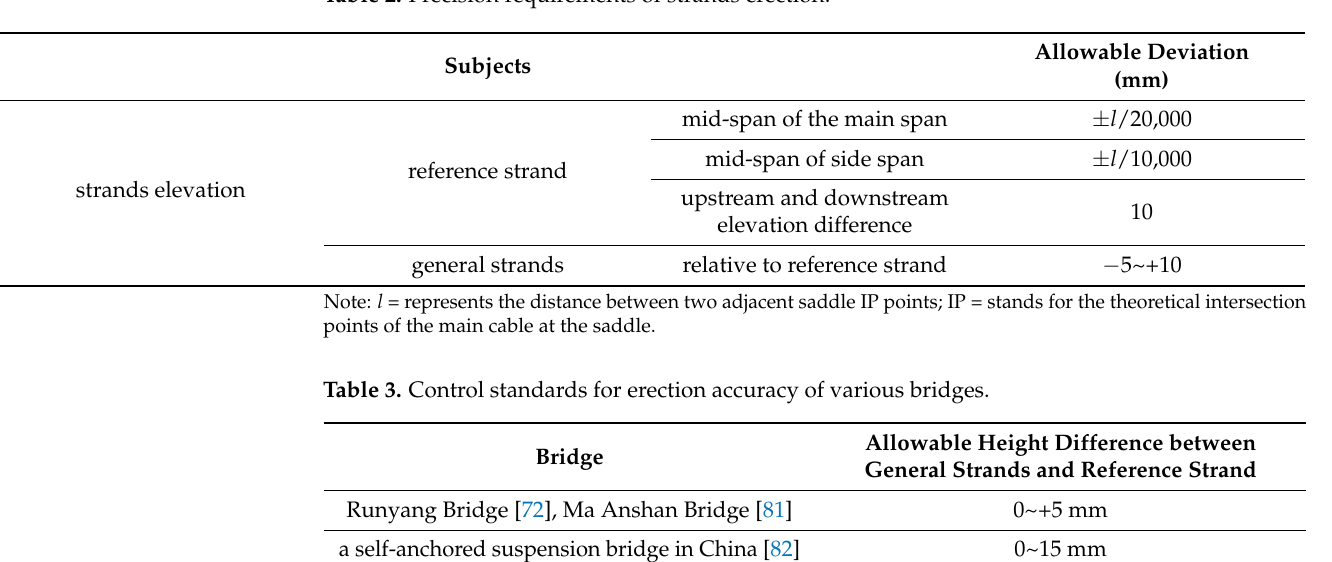
Table 2. Precision requirements of strands erection.